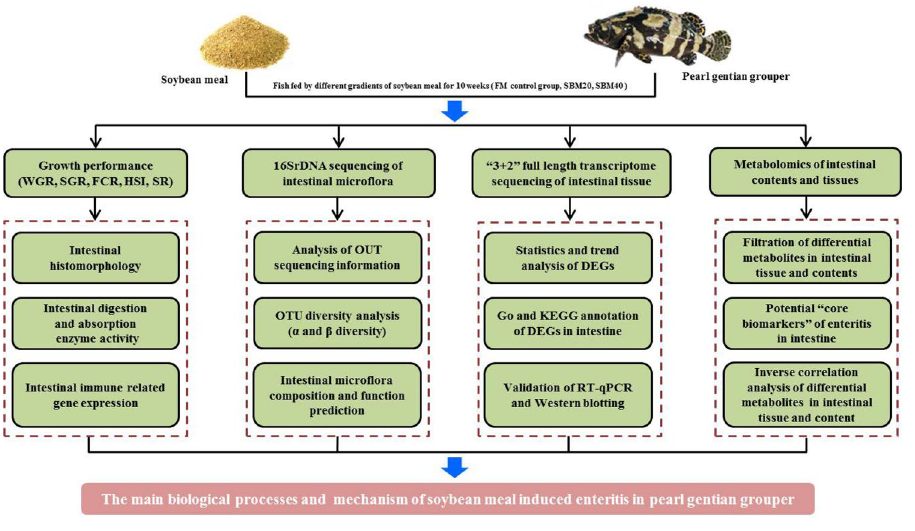
Figure 19. The brief flow chart of this